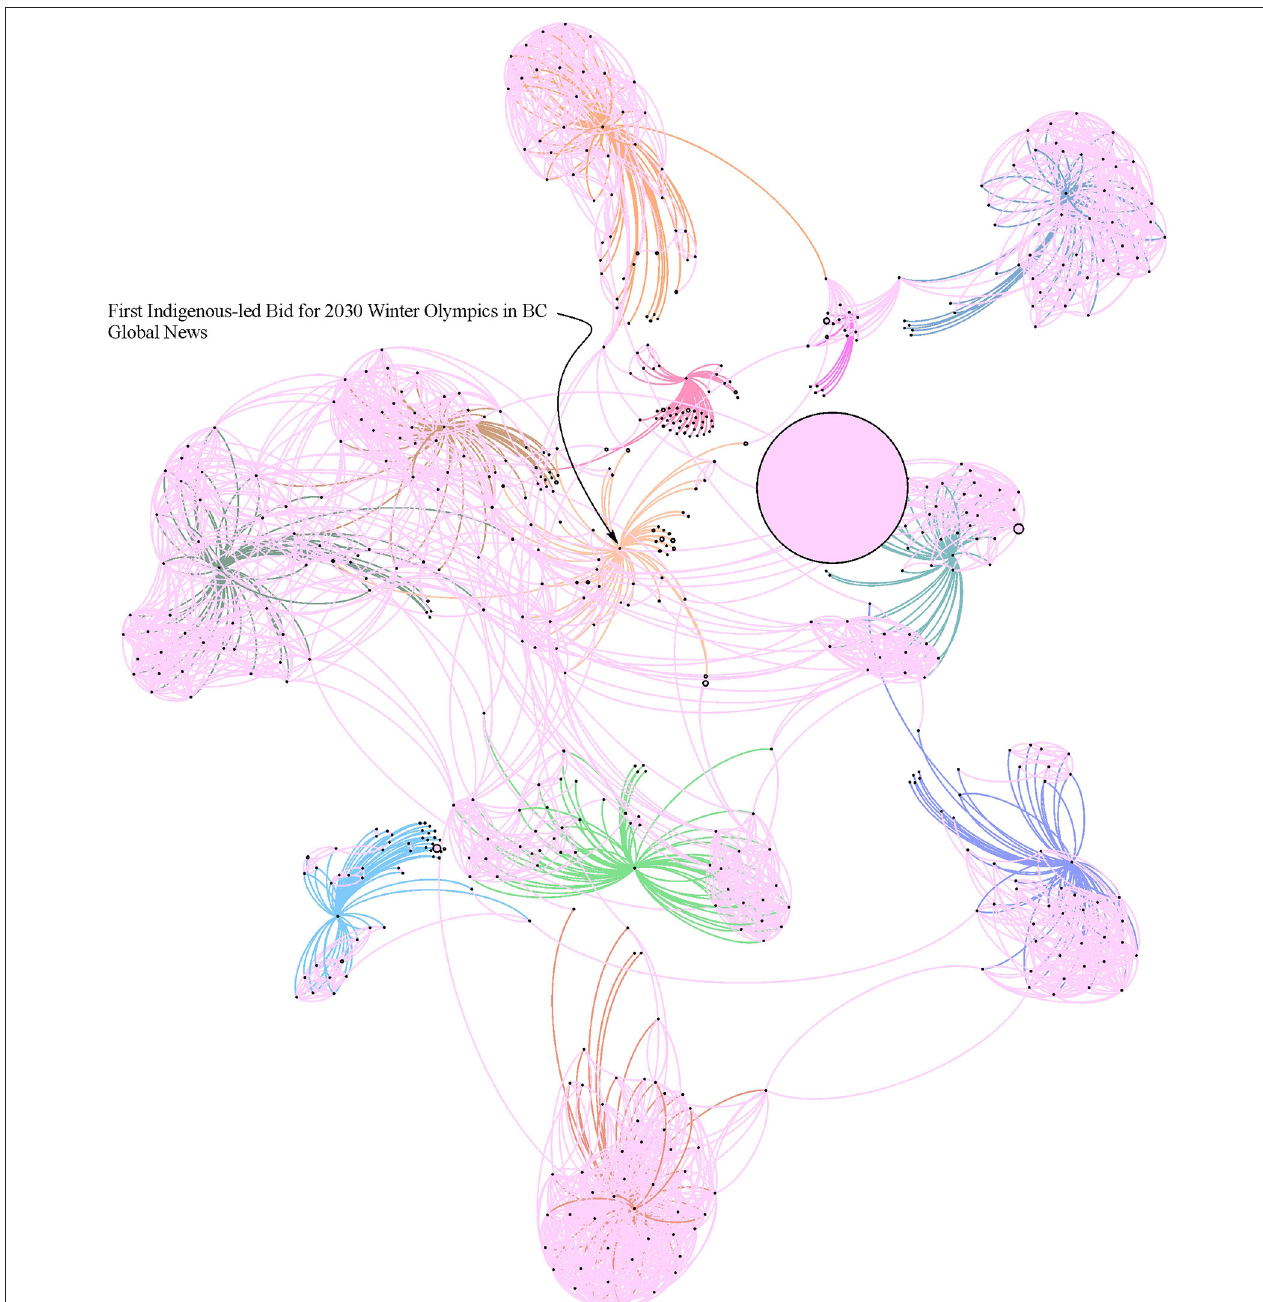
FIGURE 2 | Mapping Evolutionary Changes in Online Discourses of Race, Urbanism, Culture, and Capital. YouTube API audience recommendation correlations, using tools developed by Reider et al. (2018); figure replicates Figure 1 with the addition of a news item in December, 2021, announcing a Memorandum of Understanding as part of the very first Indigenous-led bid to host the Olympic and Paralympic Games. Graphic constructed by the